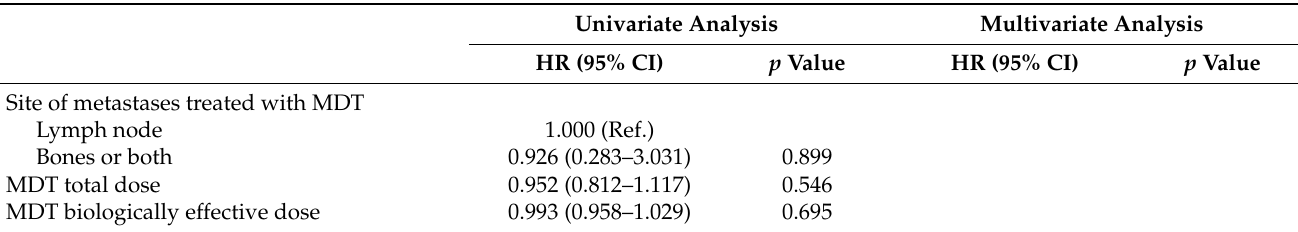
Table 2. Cont . Univariate Analysis Multivariate